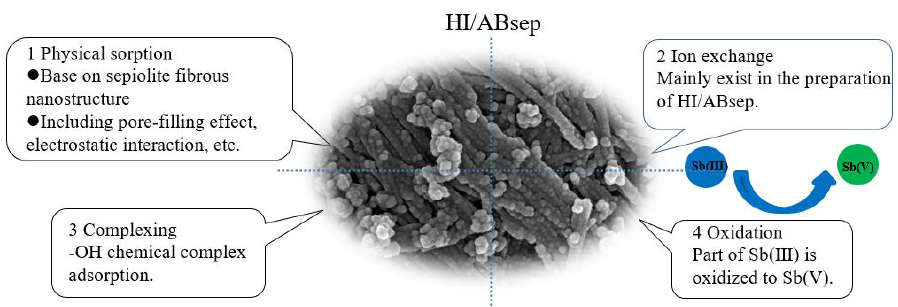
Figure 8. Mechanism of Sb (III) Removal by HI/ABsep.